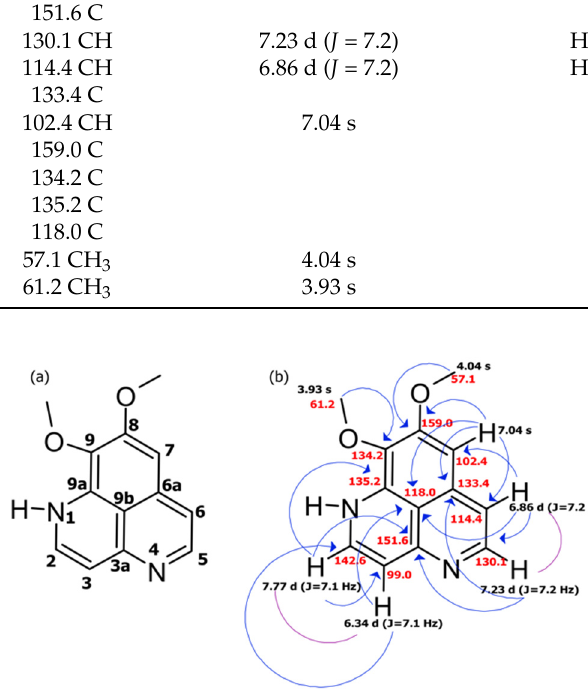
Figure 1. The purified alkaloid, aaptamine. ( a ) Structure of aaptamine. ( b ) HMBC (blue) and COSY (purple) correlations.